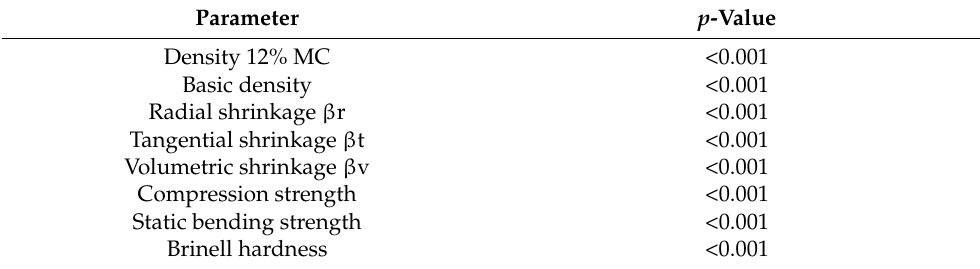
Table 6. T -test for independent sample results, for physical and mechanical properties, compared between heat-treated wood and normal wood